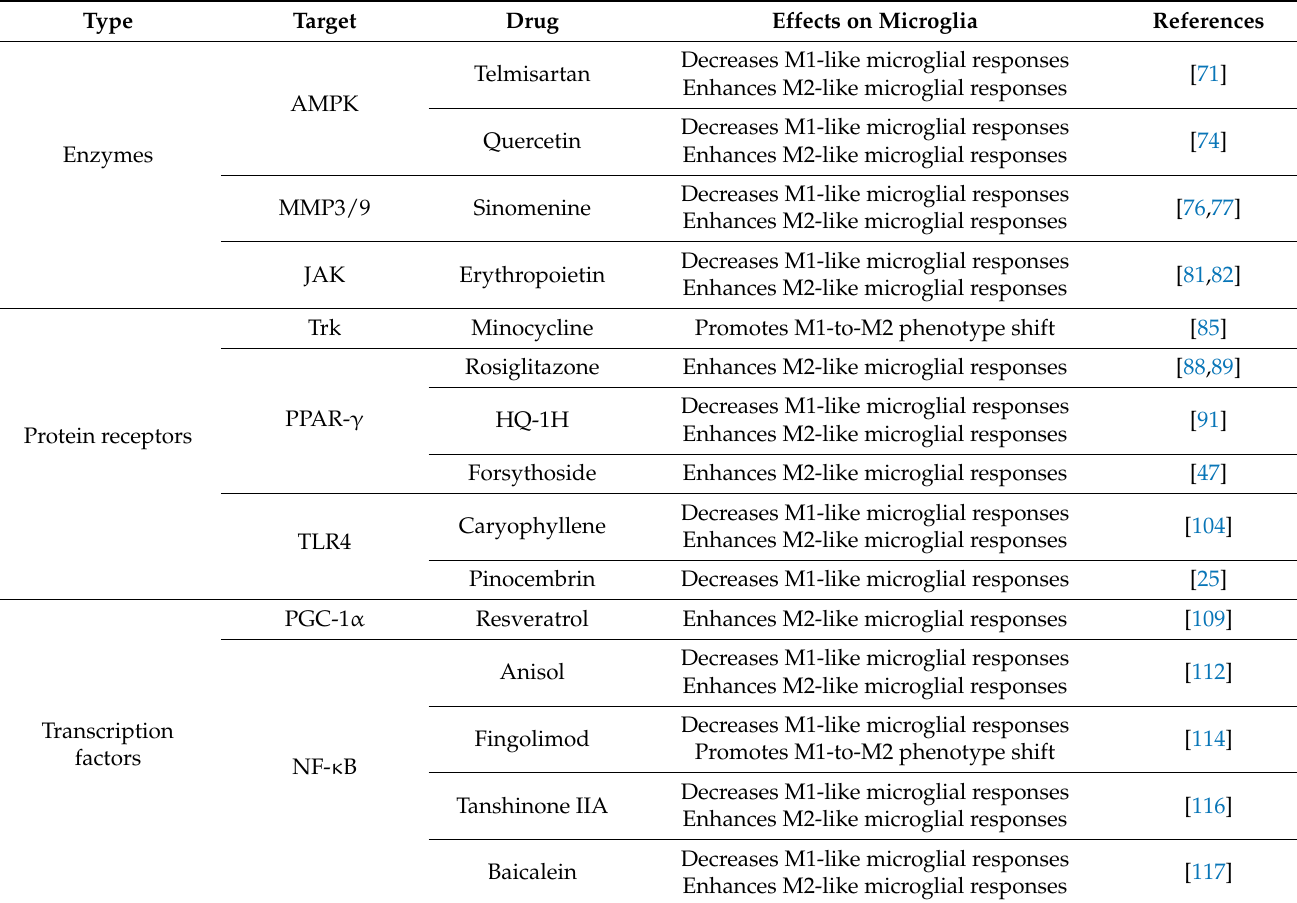
Table 2. Drugs that promote microglia